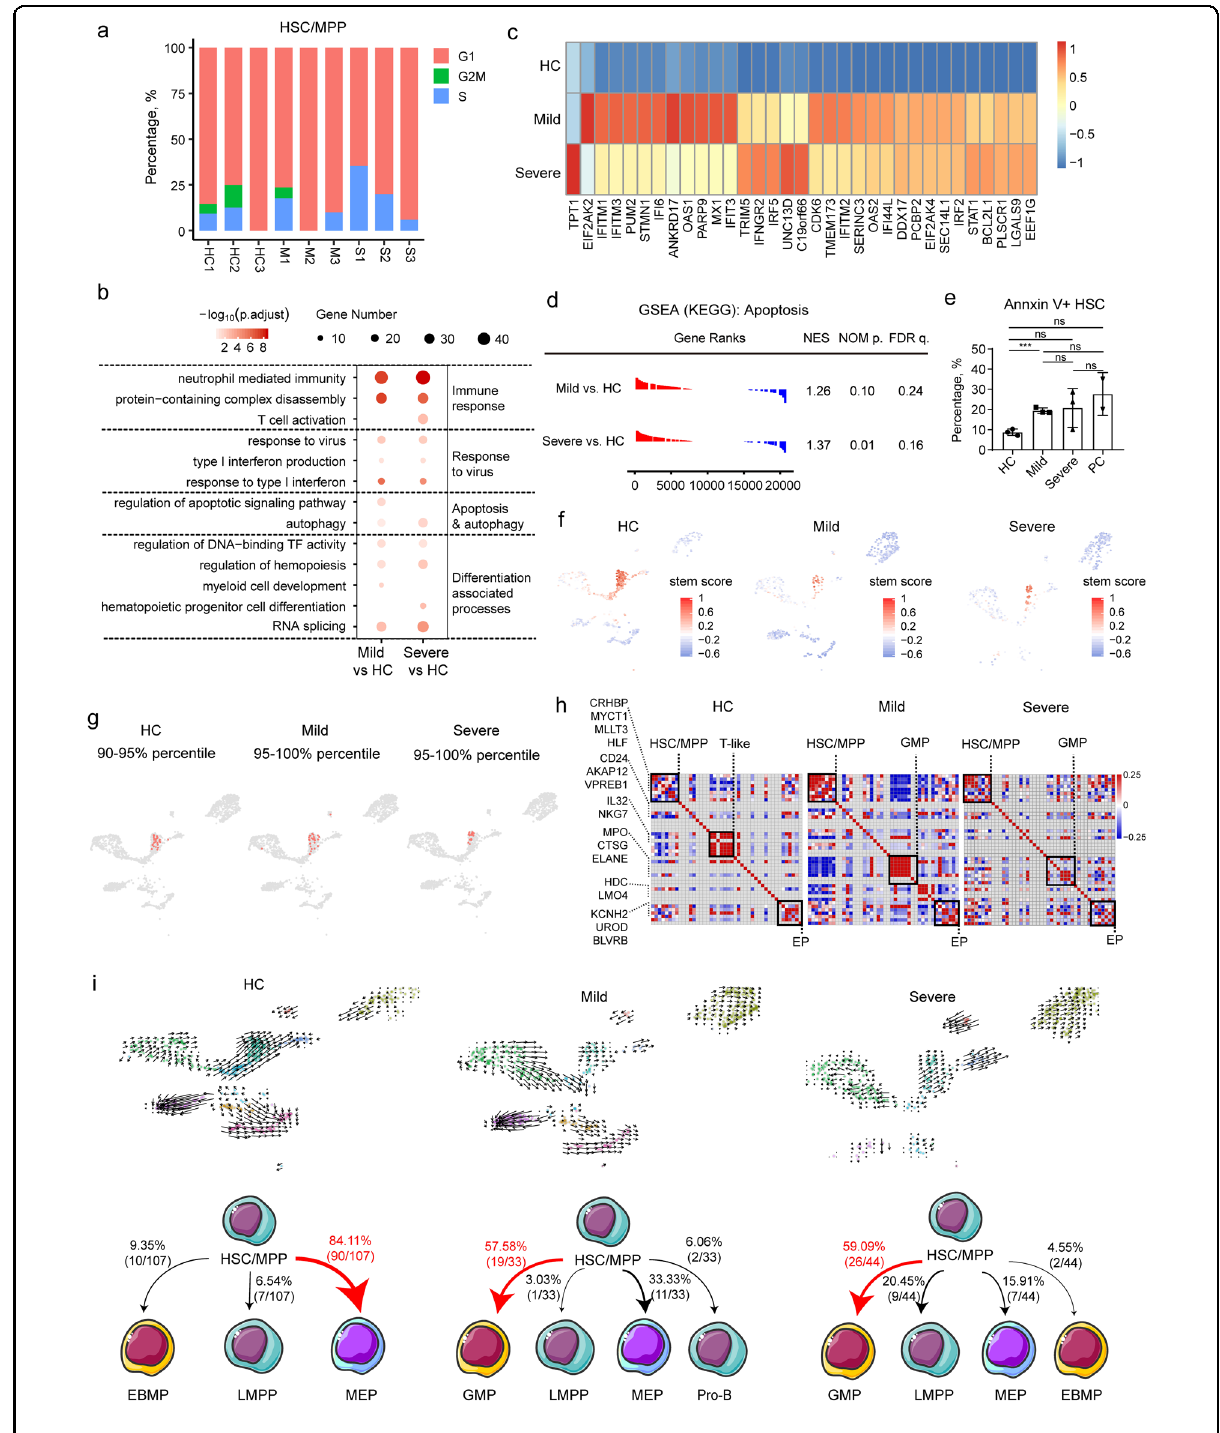
Fig. 3 (See legend on next